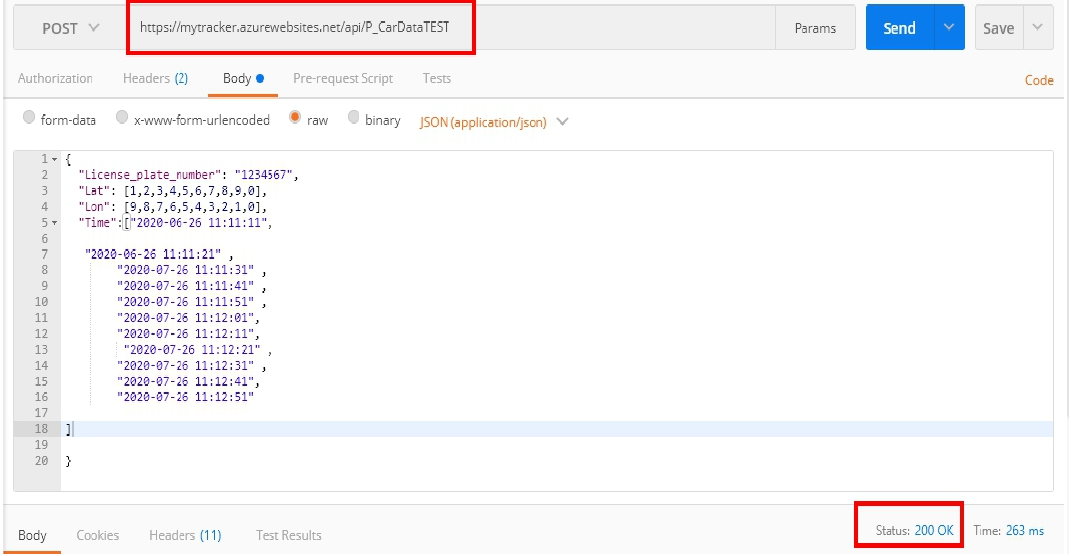
Figure 26. Third-party software Postman transmission test1.